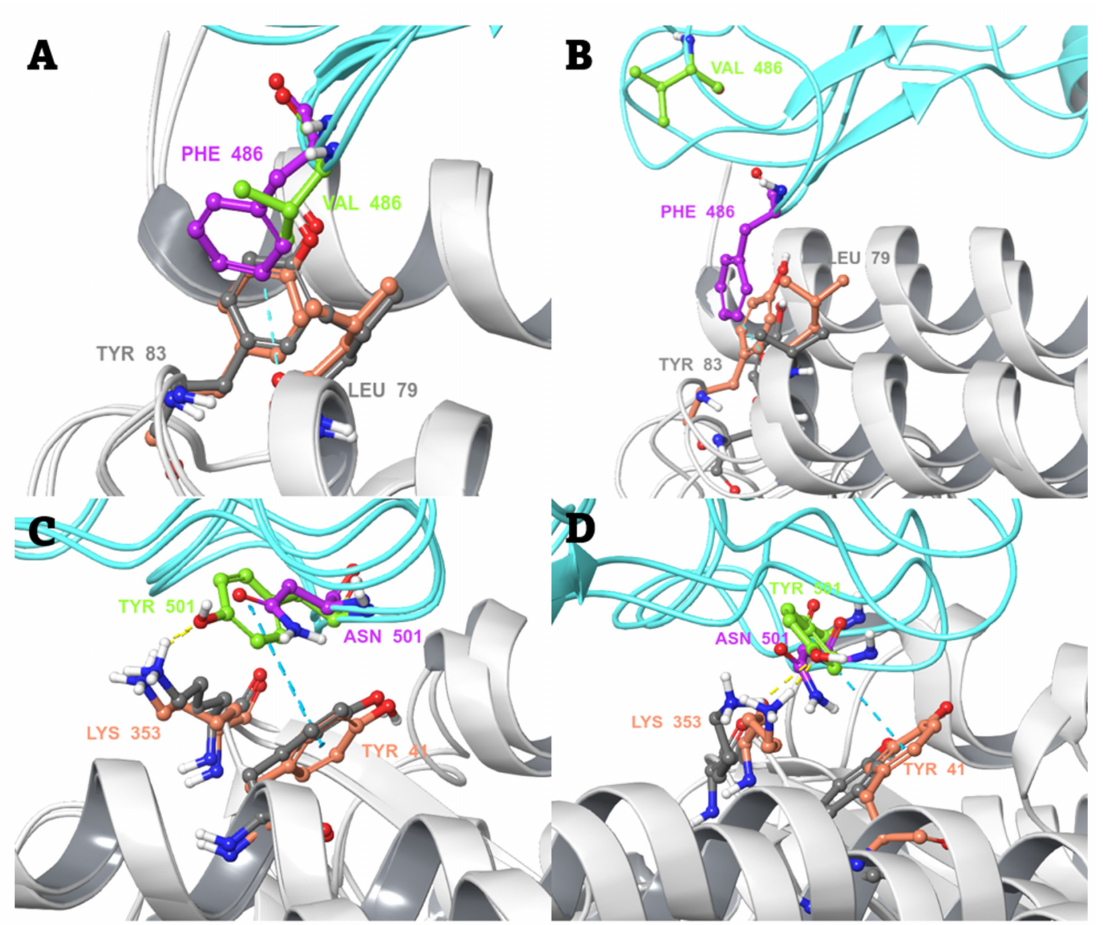
Figure 4. The change in local environment at the binding interface of SARS-CoV-2 spike RBD and hACE2 caused by single-residue mutations. The orientation and interactions of Phe486 of WT spike RBD and Val486 of the mutant, with respect to Leu79 and Tyr83 of hACE2 ( A ) before the start of production MD simulation, and ( B ) after a 200-ns MD simulation. The orientation and interactions of Asn501 of spike RBD WT and Tyr501 of the mutant, with respect to Tyr41 and Lys353 of hACE2 ( C ) before the start of production MD simulation, and ( D ) after a 200-ns MD simulation. Colour scheme: spike RBD and hACE2 in cyan and white colour cartoon, respectively. Spike RBD and hACE2 amino acid residues in pink/grey (WT complex) and green/salmon (mutant complex) elemental ball and sticks representation, respectively. Interactions are shown in dashed lines: yellow—H-bonds; light cyan—aromatic H-bonds; cyan—pi-pi